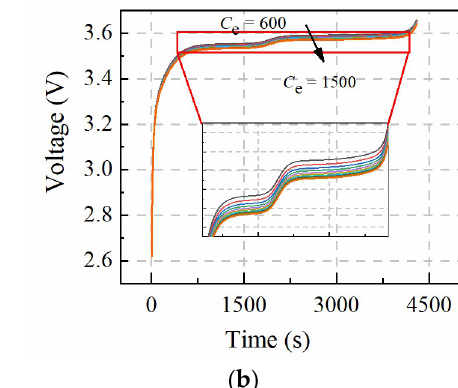
sitivity curves under 0.5 C charging rate; ( b ) Sensitivity curves under 1 C charging rate.